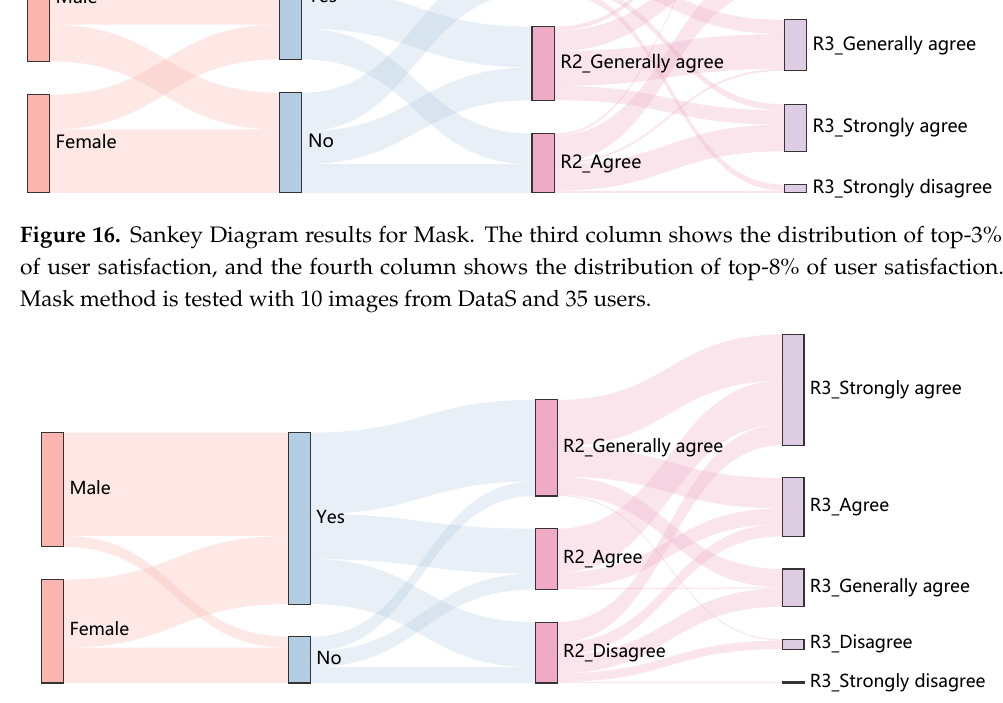
Figure 17. Sankey Diagram results for Rise. The third column shows the distribution of top-3% of user satisfaction, and the fourth column shows the distribution of top-8% of user satisfaction. Rise method is tested with 10 images from DataS and 35